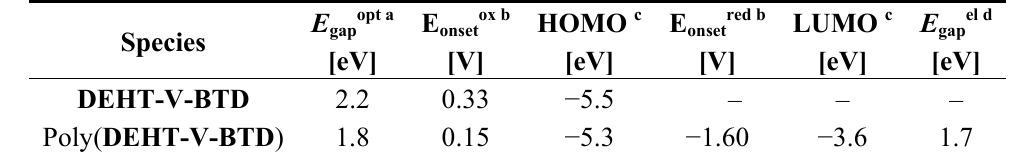
Table 1. Optical (CHCl and